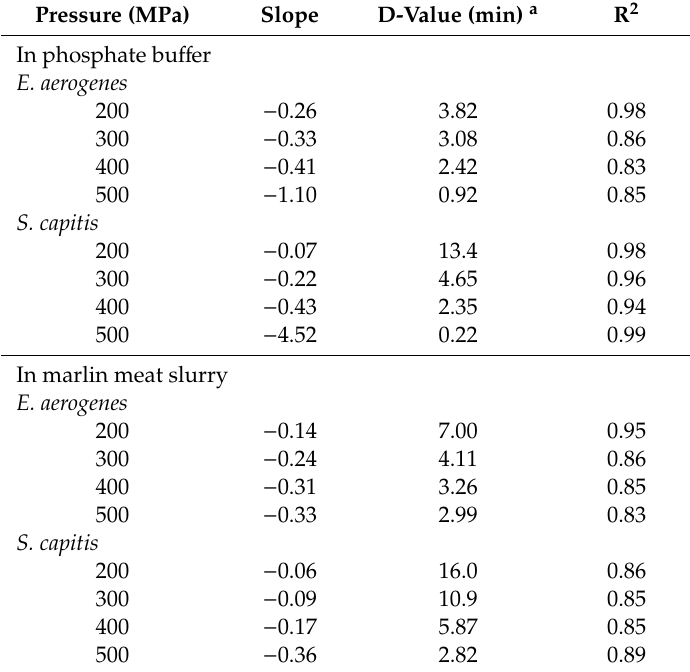
Table 1. The inactivation kinetics of high hydrostatic pressure on E. aerogenes and S. capitis in phosphate bu ff er and marlin meat slurry.